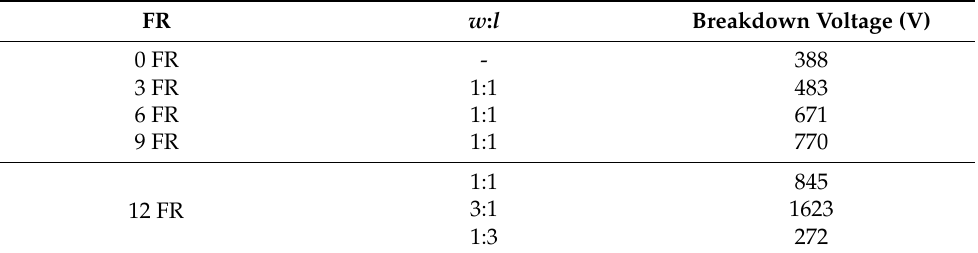
Table 1. Device simulation results of breakdown voltage with different numbers and ratios of floating rings in N+P − P+